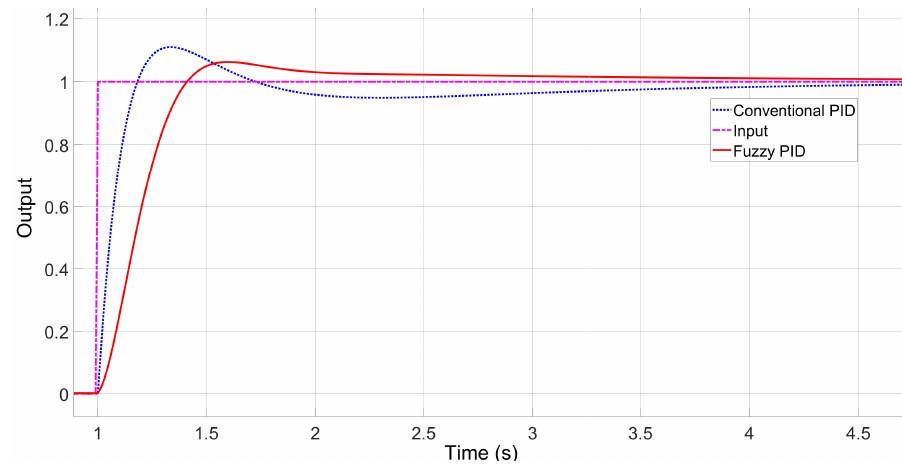
Figure 9. Simulation of response curves of step signal under three controllers.